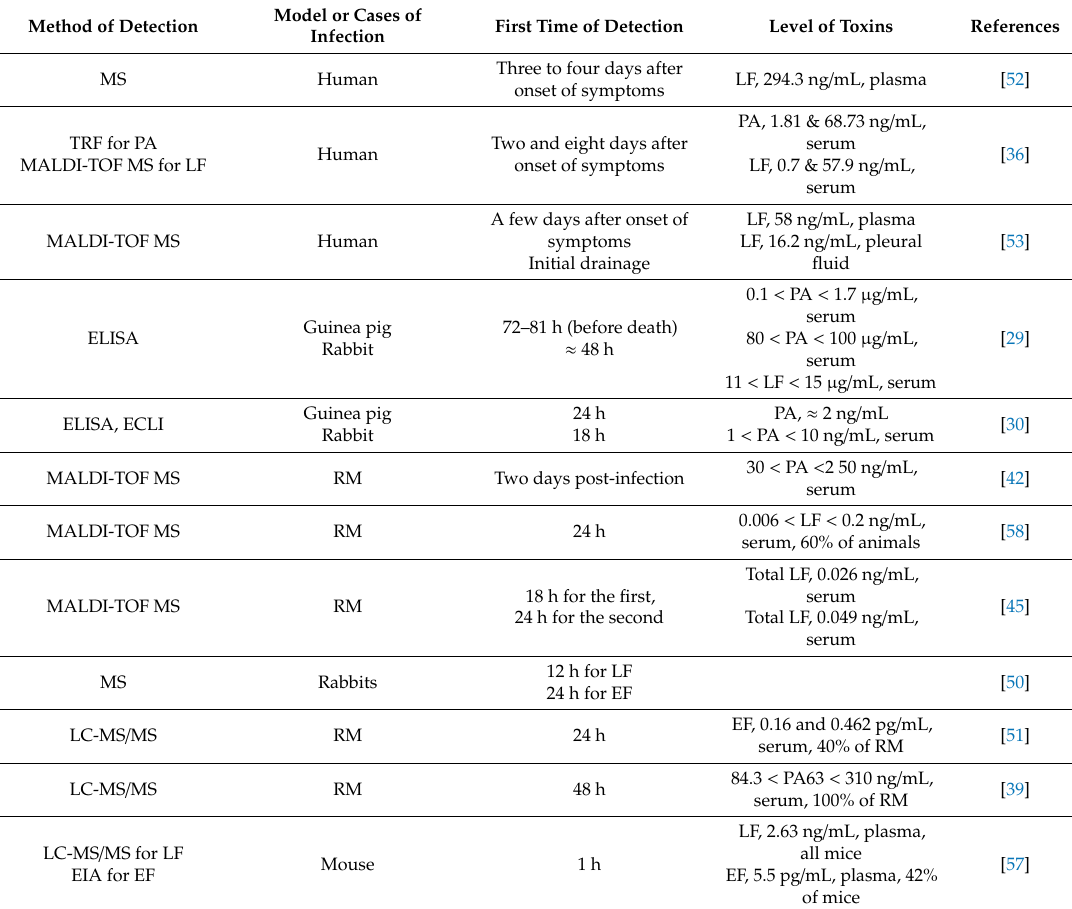
Figure 1. Evolution of LF levels during inhalation anthrax in human, adapted from references [52,53]. Table 4. First detection of PA, LF, and EF in humans with inhalation anthrax and in animal models of inhalation